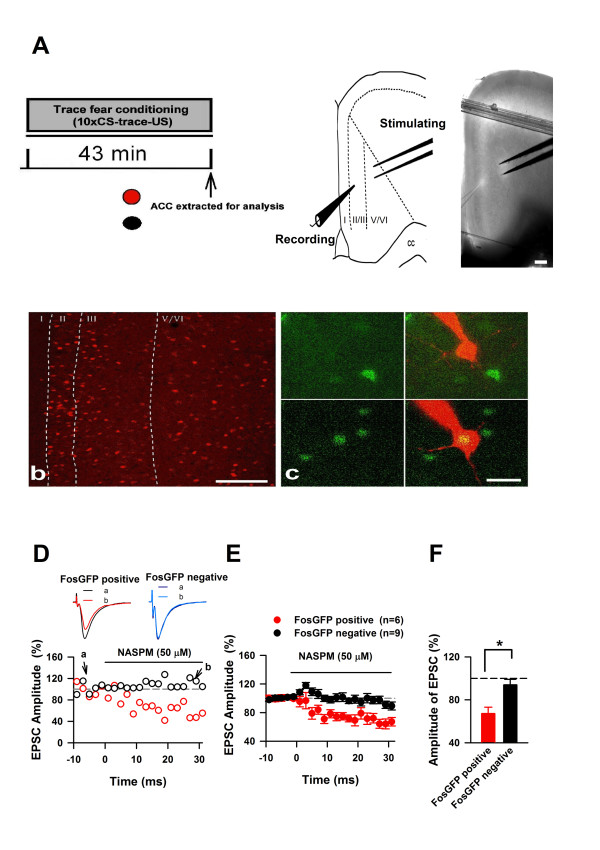
Trace fear memory is mediated by postsynaptic CP-AMPAR trafficking within the ACC. (A) (Left) We performed whole cell patch clamp recordings immediately following trace fear conditioning in ACC slices from transgenic FosGFP mice. (Right) We recorded EPSCs from pyramidal neurons in layer II/III whilst stimulating layers V/VI of the ACC. (B) Trace fear conditioning induces c-fos activity within the ACC; scale bar represents 100 μm. (C) Representative images of whole-cell patch clamp recordings of FosGFP negative pyramidal neurons (top panels), and FosGFP positive pyramidal neurons (bottom panels) as indicated by yellow showing overlap between GFP and dye loaded pipette; scale bar represents 20 μm. (D) Representative traces of single pyramidal neuron recordings before "a" and after "b" NASPM application. (E-F) NASPM significantly inhibited the amplitude of FosGFP positive neuronal EPSCs to 67% of the baseline, a reduction that is significantly greater than that observed on FosGFP negative neurons (FosGFP positive: n = 6; FosGFP negative: n = 9, t = -2.38).